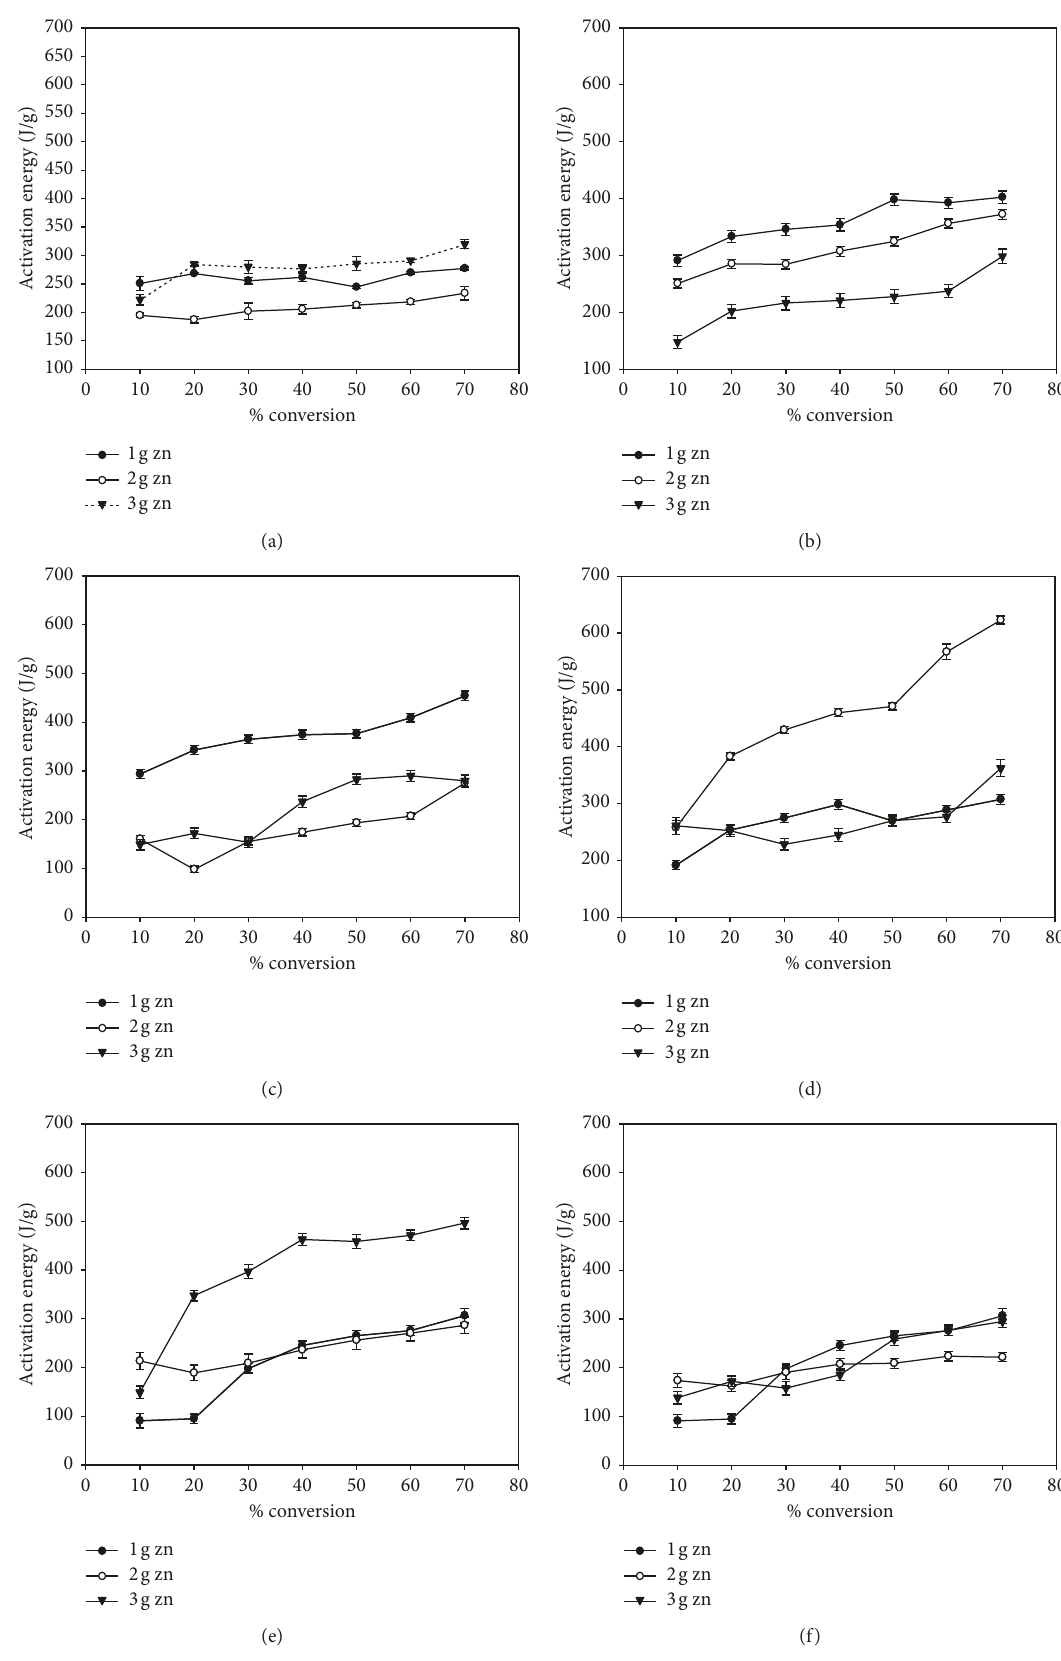
Figure 8: Activation energy of epoxy resin of cottonseed, sesame, and sunflower oils as a function of % conversion at three zinc chloride (zn) levels: (a) cottonseed oil+gluten; (b) cottonseed oil +millet flour; (c) sesame oil+gluten; (d) sesame oil+millet; (e) sunflower oil+gluten; (f) sunflower oil+millet